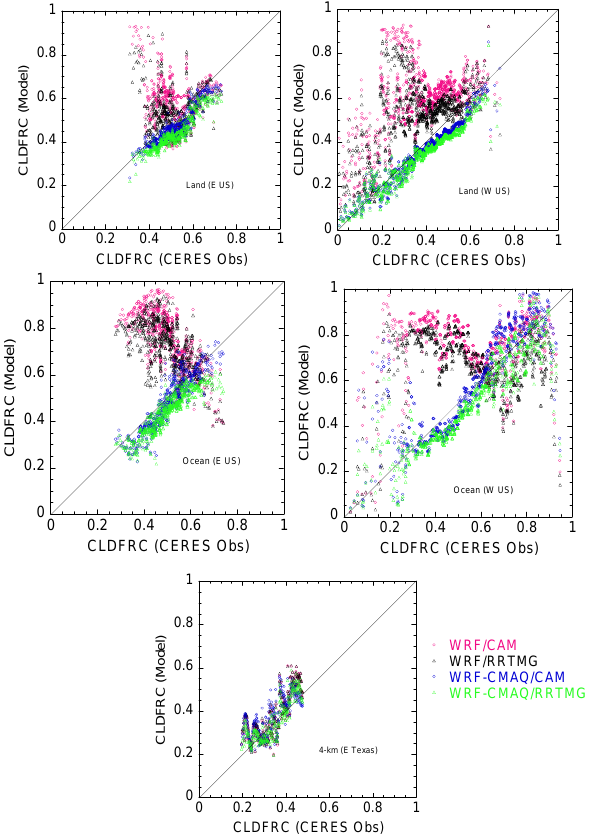
Figure 22. Same as Figure 11 but for cloud fractions (CLDFRC) for August of 2006.